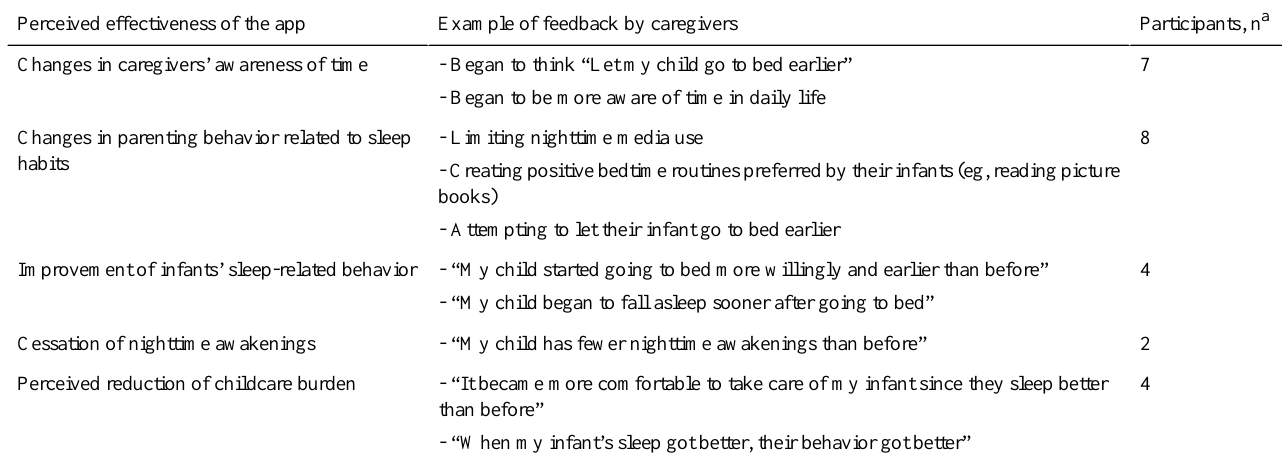
Table 2. Caregivers’perceived effectiveness of the